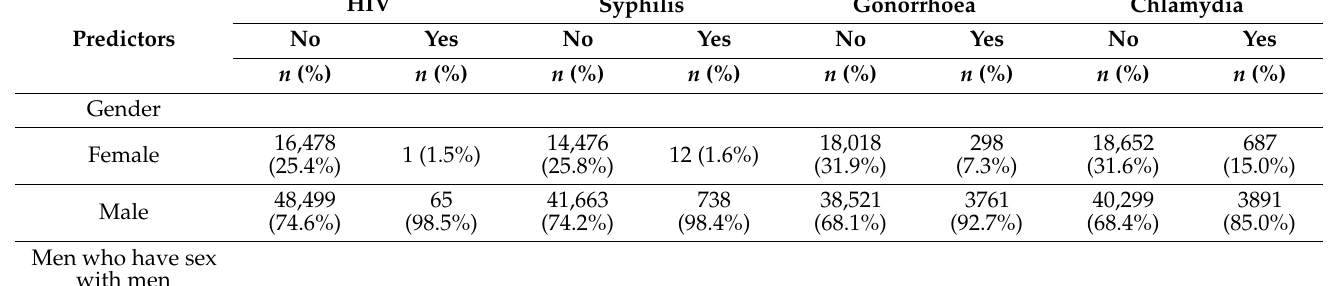
Table 1. Characteristics (proportion or median value) of the included subjects stratified by HIV and STIs over the next 12